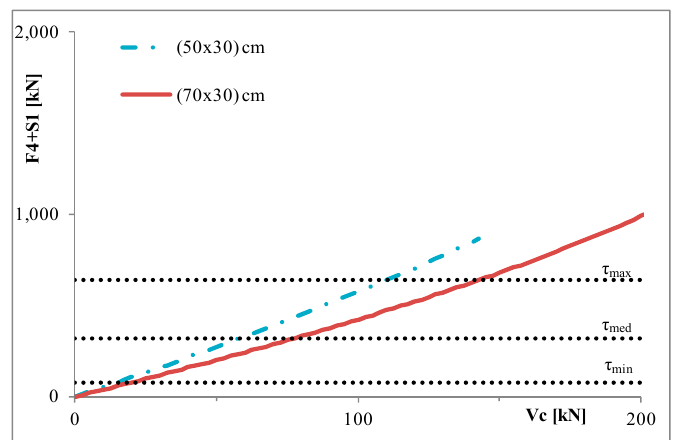
Figure 10. Parametric analysis: tensile force, F 4 , in beam bars and its threshold with variability of longitudinal beam reinforcement.